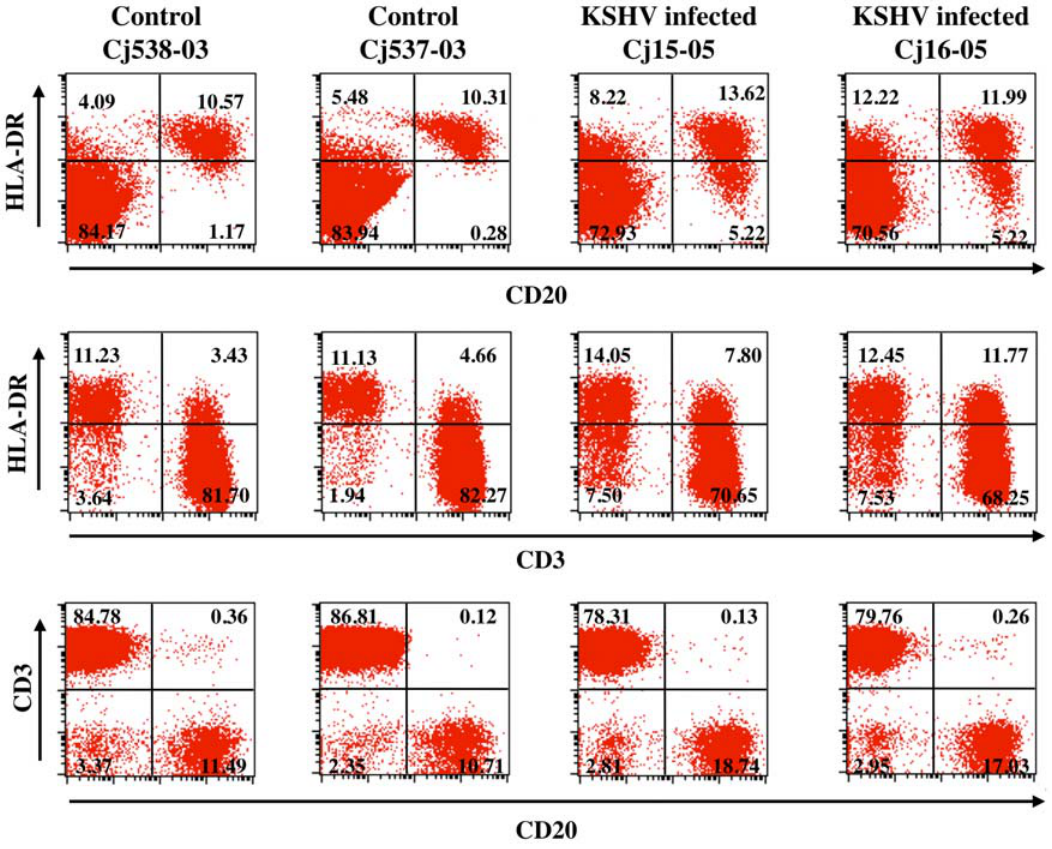
Figure 2. Increase in CD20 + B cell populations in common marmosets infected with rKSHV.219. PBMCs from Cj15-05 and Cj16-05 at day 210 P.I. were used for flow cytometry analysis with anti-CD3, anti-CD20, and anti-HLA-DR to identify T cells, B cells, and activated lymphocytes, respectively. The PBMCs from uninfected marmosets Cj538-03 and Cj537-03 were used as controls. The numbers in the boxes indicate percentages relative to the entire PBMC population.